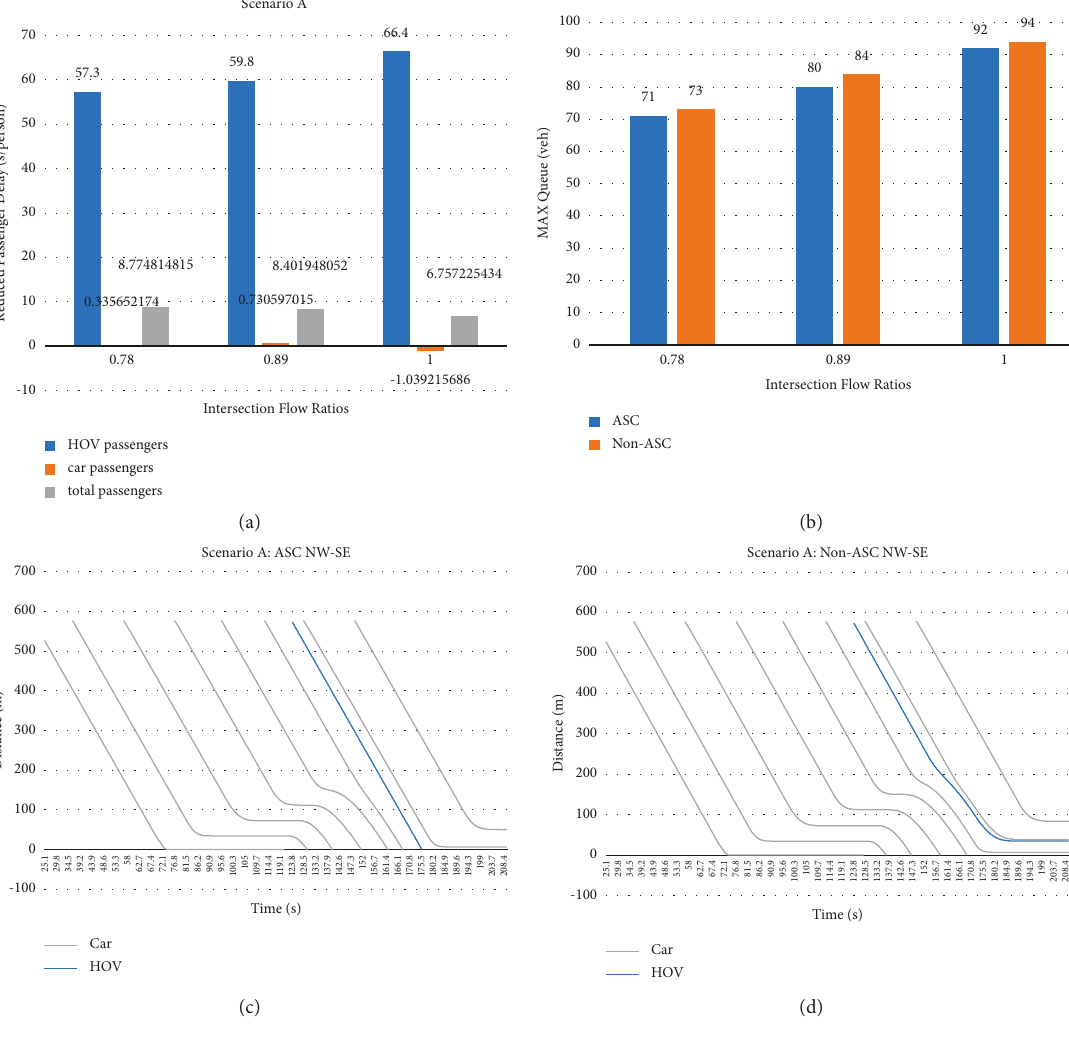
Figure 7: ASC optimization results in scenario A (a) Reduced passenger delays (b) Max queue (c) Vehicle trajectories under ASC (d) Vehicle trajectories under fixed